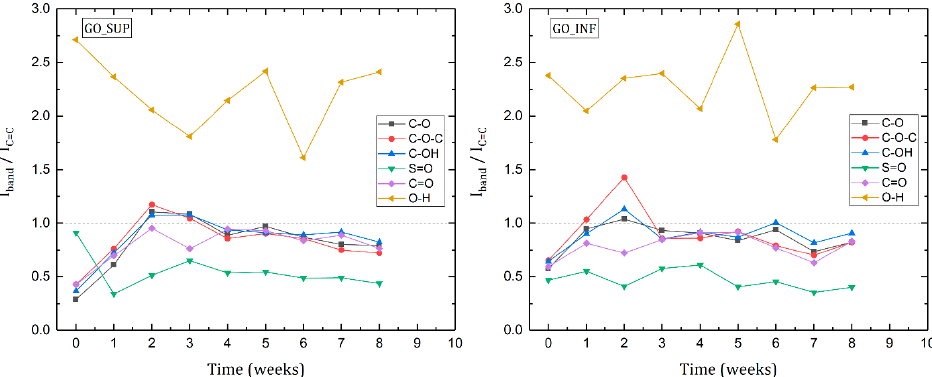
Figure 8. The intensity ratio of the functional group absorption bands and the 1640 cm − 1 reference band for the dried GO_SUP ( left ) and GO_INF ( right ) samples over a time period of eight weeks after synthesis.